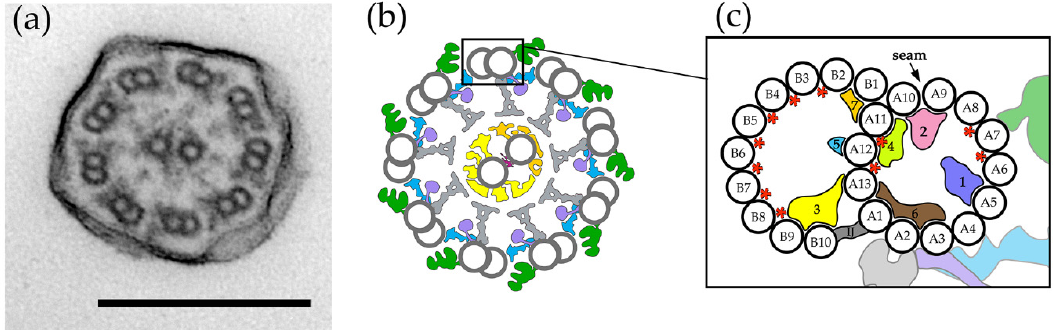
Figure 3. Organization of motile cilia ultrastructure: ( a ) transmission electron microscopy (TEM) cross-section of a Tetrahymena cilium, scale = 200 nm; ( b ) a schematic representation of the organization of axonemal macro-complexes: ODAs (outer dynein arms, in green), IDAs (inner dynein arms, in violet), RSs (radial spokes, in grey), the N-DRC (nexin–dynein regulatory complex, in blue), and the central apparatus (two microtubules, with their projections in yellow and dark yellow, and the bridge connecting the central microtubules in red); ( c ) schematic representation of the outer doublet showing protofilament numbering (A1–A13: protofilaments of the A-tubule, B1–B10: protofilaments of the B-tubule), position of the globular MIPs (microtubule inner proteins, 1–7), and the position of the outer doublet macro-complexes (colored as in (b)); the positions of the filamentous MIPs are marked by red stars. ( c ) Modified from [5,42–44,51].